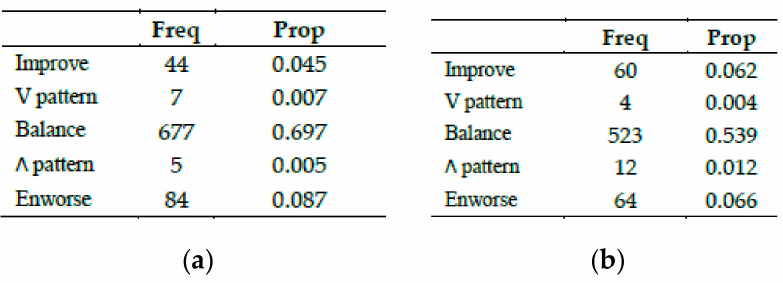
Figure 36. ( a ) Changing patterns in relationships with friends. ( b ) Changing patterns in labour